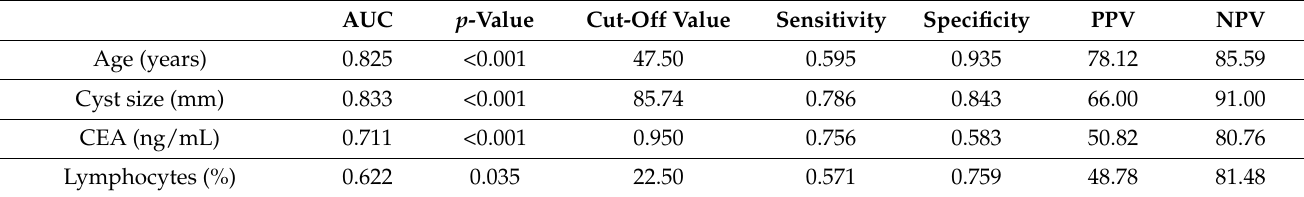
Table 4. The cut-off values discriminating EAOC from benign OE in the current cohort. AUC p